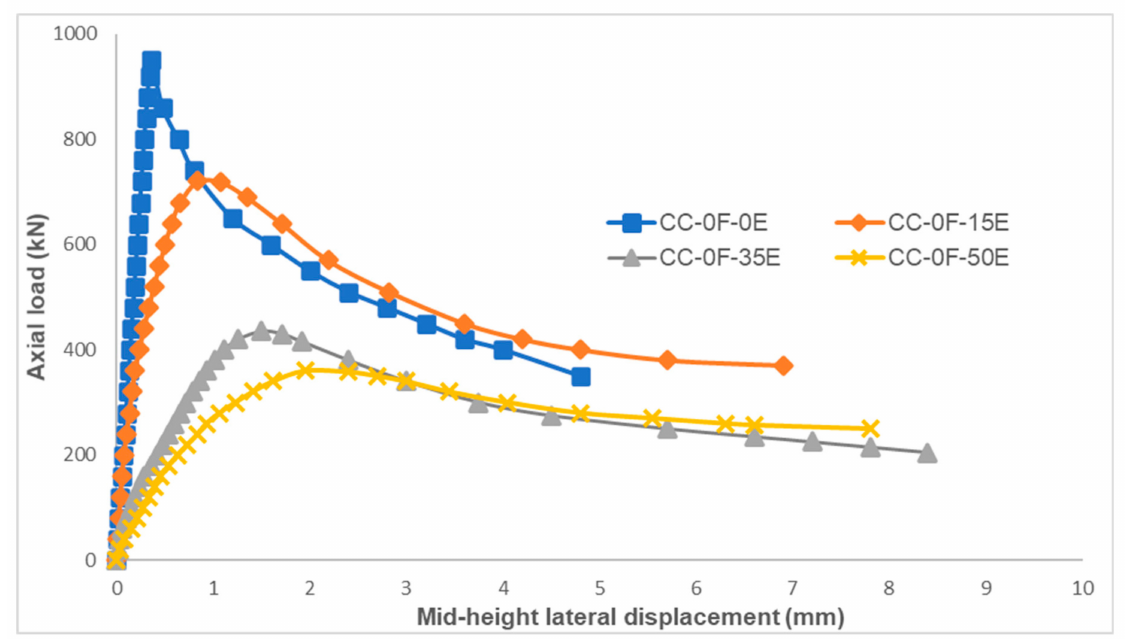
Figure 12. The axial load–lateral displacement behavior of CC columns.